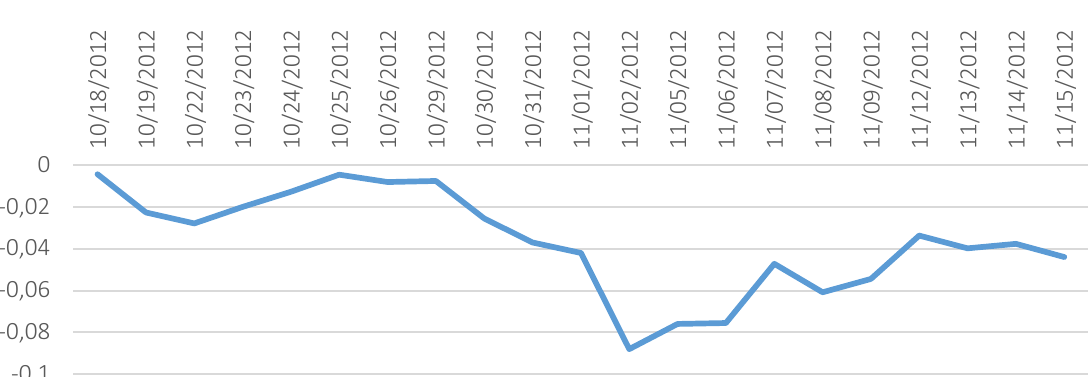
Figure 2. ACB’s CAR [–10;10] for the second event in